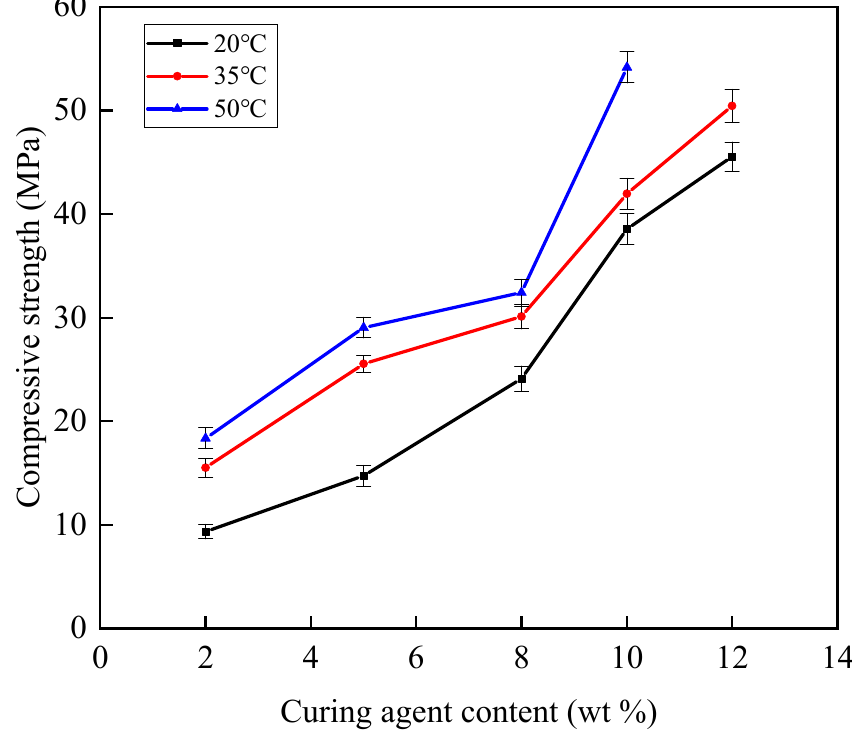
Figure 10. The compressive strength changes of sealant with varying amounts of curing agent.